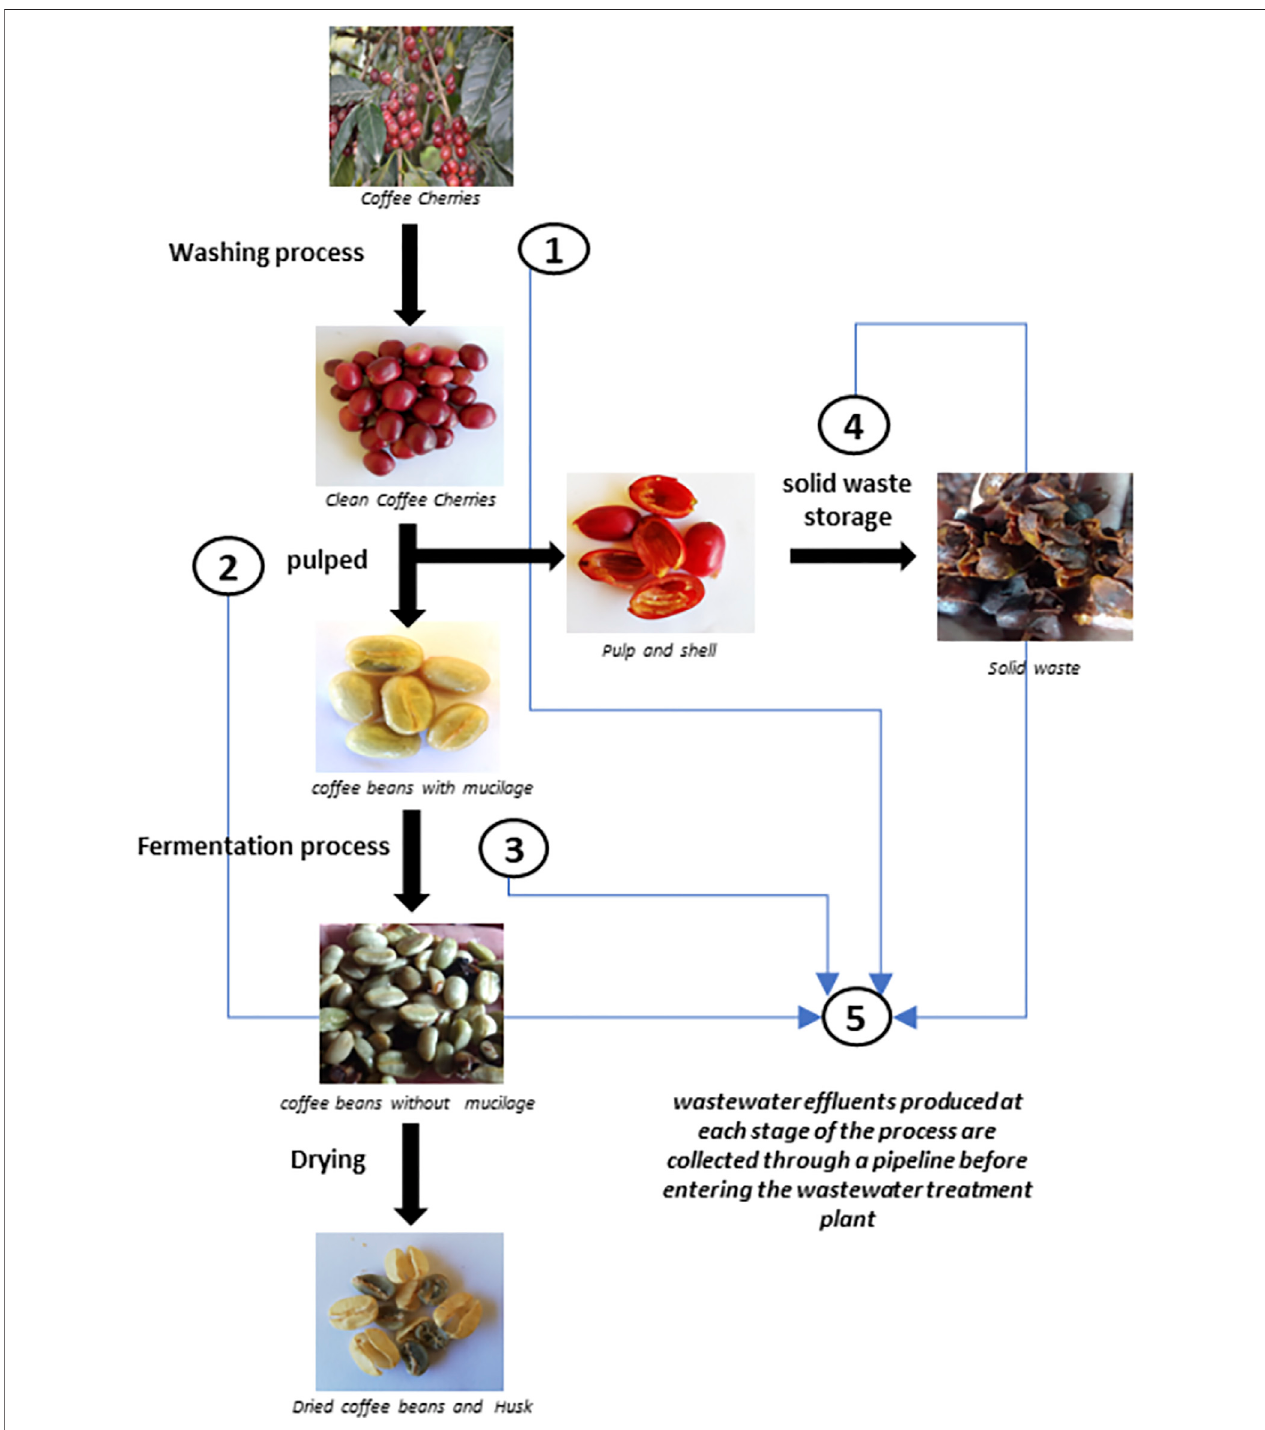
FIGURE 1 | Schematic representation of the wet processing coffee